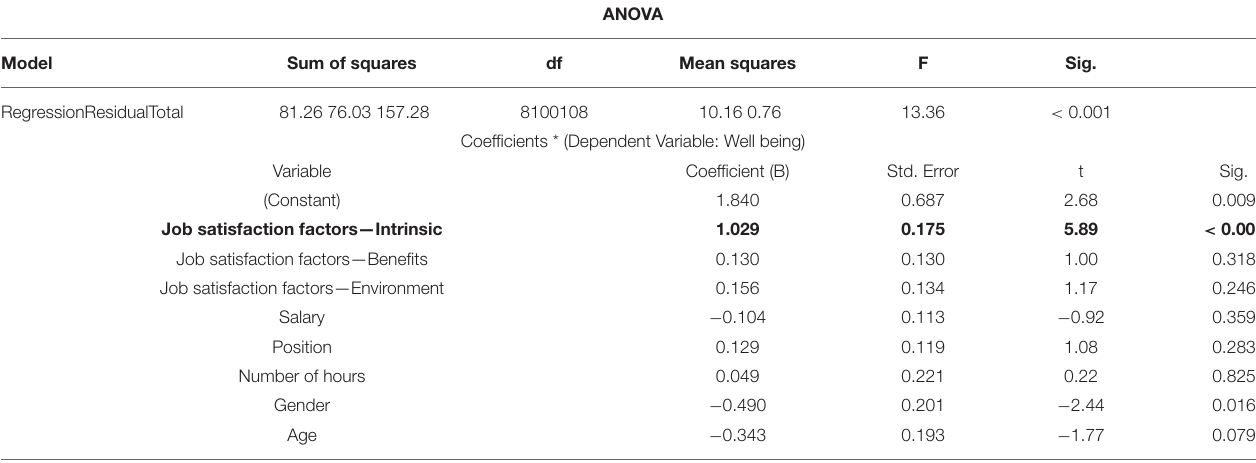
TABLE 8 | Results of the multiple linear regression model predicting well being as a function of job factors, gender, and age.